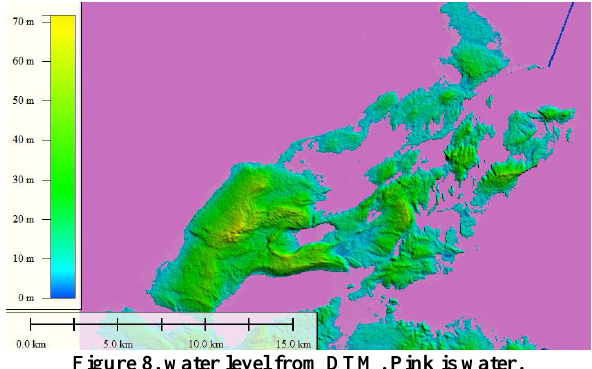
Figure 8. water level from DTM. Pink is water. Flow accumulation application, the DTM used produces a higher order of surface flow or high surface flow detail. The flow accumulation extraction method is the steepest slope. This method takes into account the slope and height difference. Figure 9 is flow accumulation.